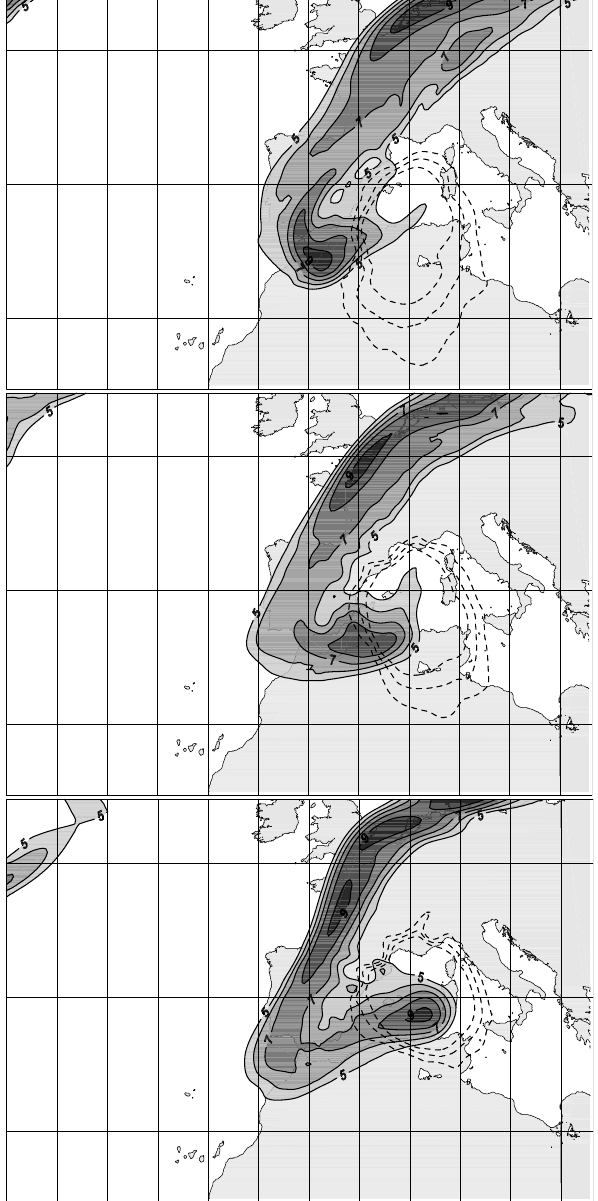
Fig. 12. C21–23 Simulation. Potential vorticity (PVU, 1PVU=10 − 6 m 2 s − 1 K kg − 1 ) greater than 5PVU at 250hPa for (a) 12:00UTC, 21December, (b) 18:00UTC, 21December and (c) 00:00UTC, 22December. Dashed lines represent 999, 1000 and 1001hPa surface pressure isolines surrounding the low center.